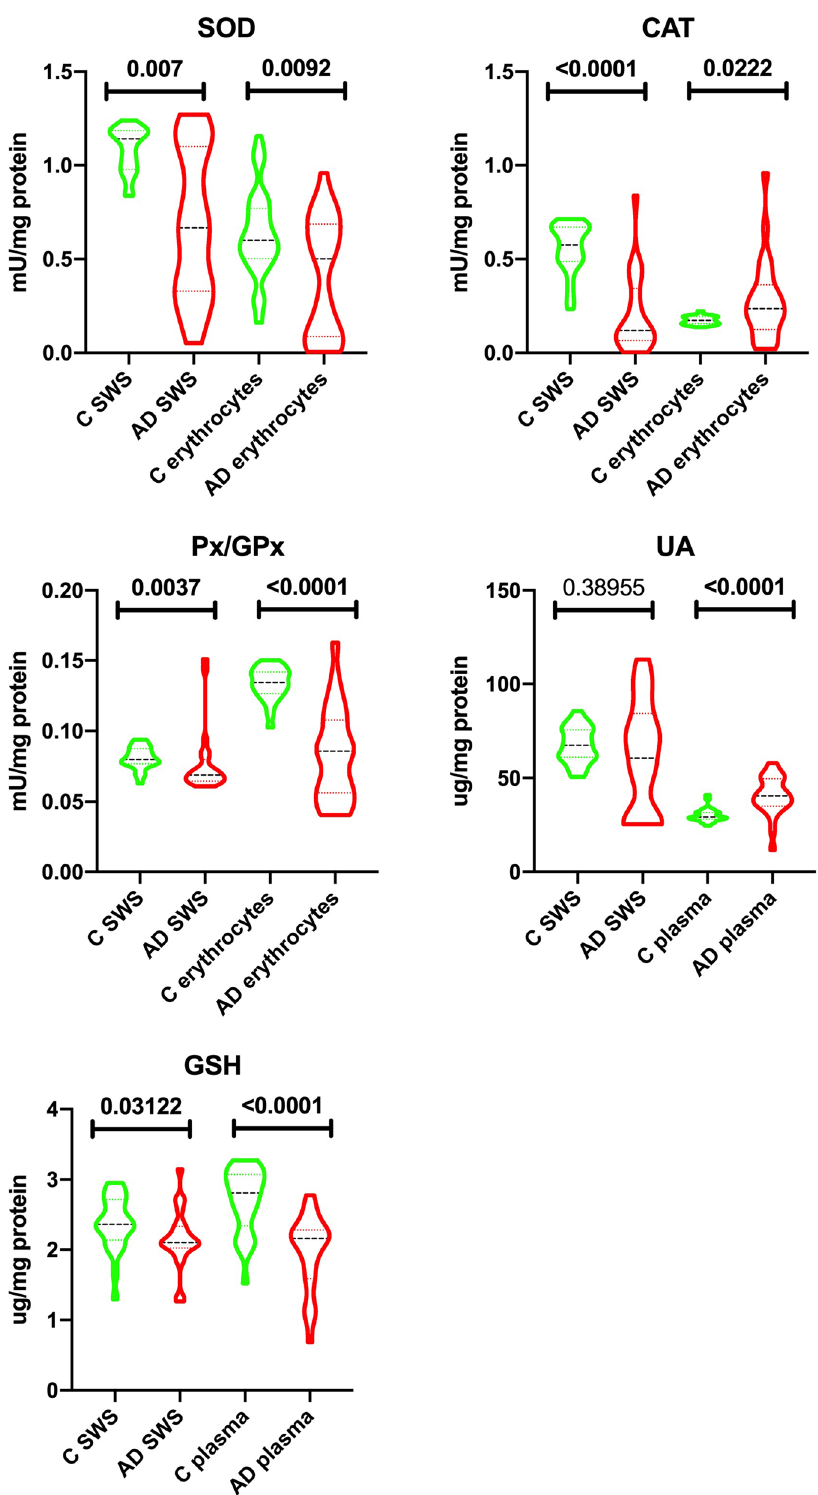
Figure 2. Salivary and erythrocytes/plasma antioxidant barrier in patients with Alzheimer’s disease and the control group. SOD—superoxide dismutase; CAT—catalase; Px—peroxidase; GPx—glutathione